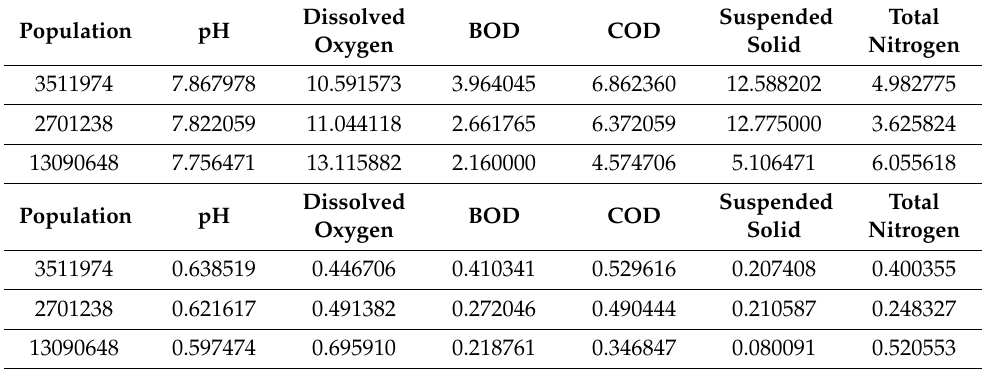
Table 7. Example of data scaling (upper: original data, lower: normalized data).